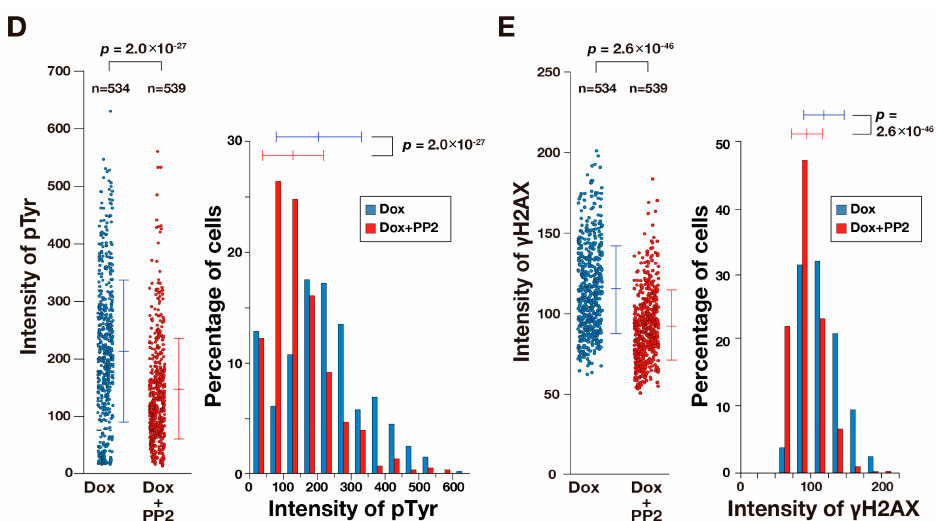
Figure 2. v-Src induces DNA damage. ( A ) HCT116/v-Src cells were cultured with 1.0 μ g/mL Dox for 12 h in the presence or absence of 10 μ M PP2. The cells were fixed with PBS containing 4% paraformaldehyde and 20% methanol for 20 min at room temperature and stained for pTyr (green), γ H2AX (red), and DNA (blue). Arrows indicate cells showing lower levels of pTyr staining. The boxed regions are magnified in the right panels. Bars, 20 μ m; ( B ) HCT116/v-Src cells were cultured with or without 1.0 μ g/mL Dox for 12 h. The cells were fixed with PBS containing 20% methanol and 4% formaldehyde for 20 min at room temperature and stained for γ H2AX and DNA. The fluorescence signals were analyzed by an image analyzer. The left histogram shows the number of γ H2AX foci per nucleus. The right histogram shows the total area of γ H2AX foci per nucleus. The results represent the mean ± S.D. None, n = 2870; 1.0 μ g/mL Dox, n = 686; ( C ) Cells were cultured with Dox at the indicated concentrations for three days or 300 ng/mL Adriamycin (ADR) for one day as a positive control. Whole cell lysates were subjected to a Western blot analysis. Blots were probed with anti- γ H2AX and anti-actin (loading control). A representative result of two independent experiments is shown; ( D , E ) Cells were cultured with 1.0 μ g/mL Dox for 12 h in the absence or presence of 10 μ M PP2. Then, the cells were fixed and stained as described in A . The fluorescence signals were analyzed by an image analyzer. In D , fluorescence intensities of pTyr in individual cells were plotted with the mean ± S.D. ( n > 534) in the left, and data were converted to a histogram plot shown on the right; In E , fluorescence intensity of γ H2AX in an individual nucleus was plotted with the mean ± S.D. ( n > 534) on the left, and data were converted to a histogram plot as shown on the right. p values were calculated using a two-tailed Student’s t -test. DNA damage elicits a broad range of cellular responses, such as cell cycle arrest, apoptosis, and DNA repair through the activation of the ATM/ATR pathway. ATR phosphorylates Chk1 at Ser345, and ATM phosphorylates Chk2 at Thr68 and KAP1 at Ser824 [15,16]. These phosphorylations were examined to confirm that v-Src caused DNA damage. As positive controls, phosphorylated bands of Chk1 and KAP1 were clearly observed upon treatment of cells with Adriamycin (ADR) and bleomycin (BLM) for one day before lysate preparation. HCT116/v-Src cells were treated with Dox for three days and subjected to a Western blot analysis. Treatment of cells with Dox increased phosphorylations of KAP1 at Ser824 (Figure 3A), Chk2 at Thr68 (Figure 3B), and Chk1 at Ser345 (Figure 3C). These results confirm that v-Src causes DNA damage and elicits activation of the ATM/ATR pathway.